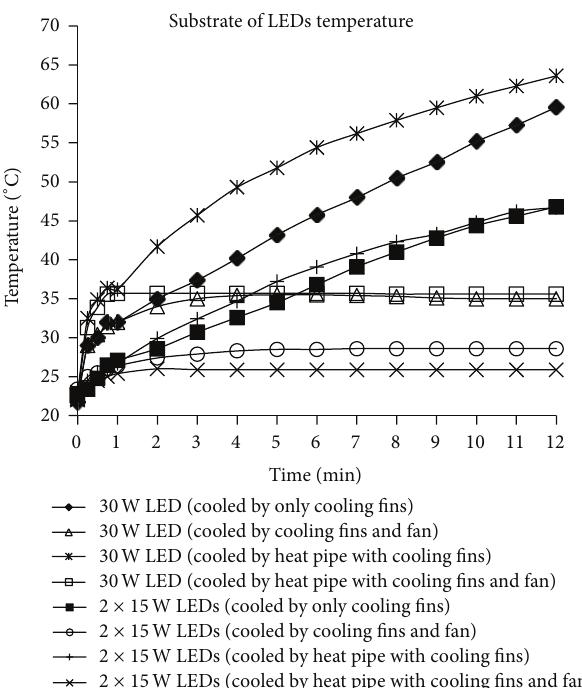
Figure 6: The change of the substrate of LED temperature over time during the cooling process of LEDs with 30 W and 2 × 15 W LEDs configuration as a means of integrated fin heat sink design with or without fan and heat pipe cooling